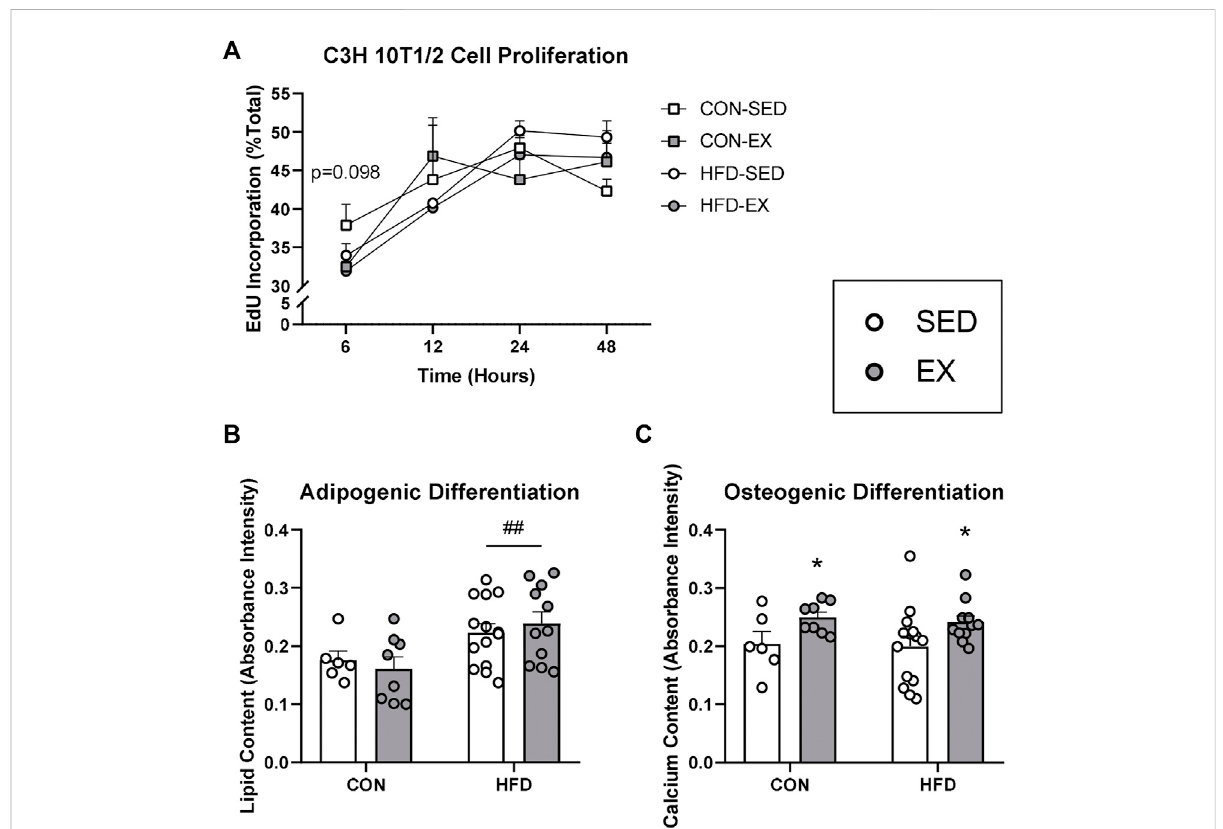
FIGURE 5 Extracellular vesicles (EVs) impact mesenchymal stromal cell (MSC) differentiation activity in vitro. C3H/10T1/2 MSCs were differentiated into either adipocytesand stained withOil Red Oor osteoblasts andstained withAlizarin Red S dye. (A) Proliferation by EdUstainat6, 12,24, and 48 h (B) EVs from high-fat diet-fed mice increased adipogenic differentiation and (C) EVs form exercise-trained mice increased osteogenic differentiation. * p < 0.05 main effect of exercise; ## p < 0.01 main effect of high-fat diet ( n = 6 – 14 per